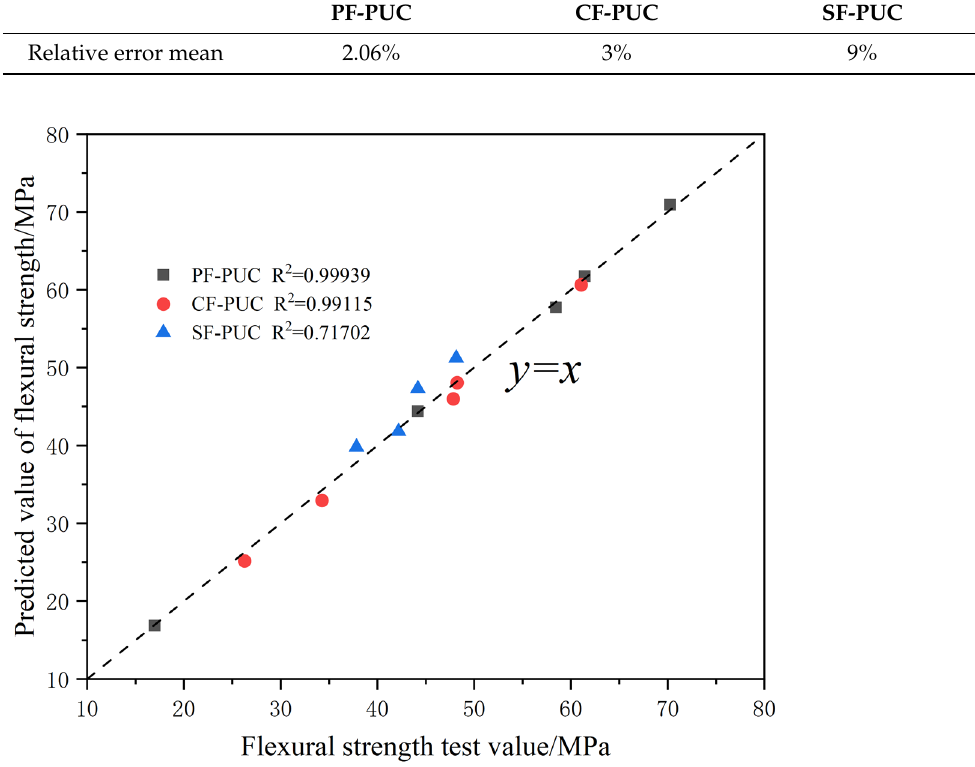
Figure 9. The relationship between the test value and predicted value of the flexural strength of the tested samples. tested